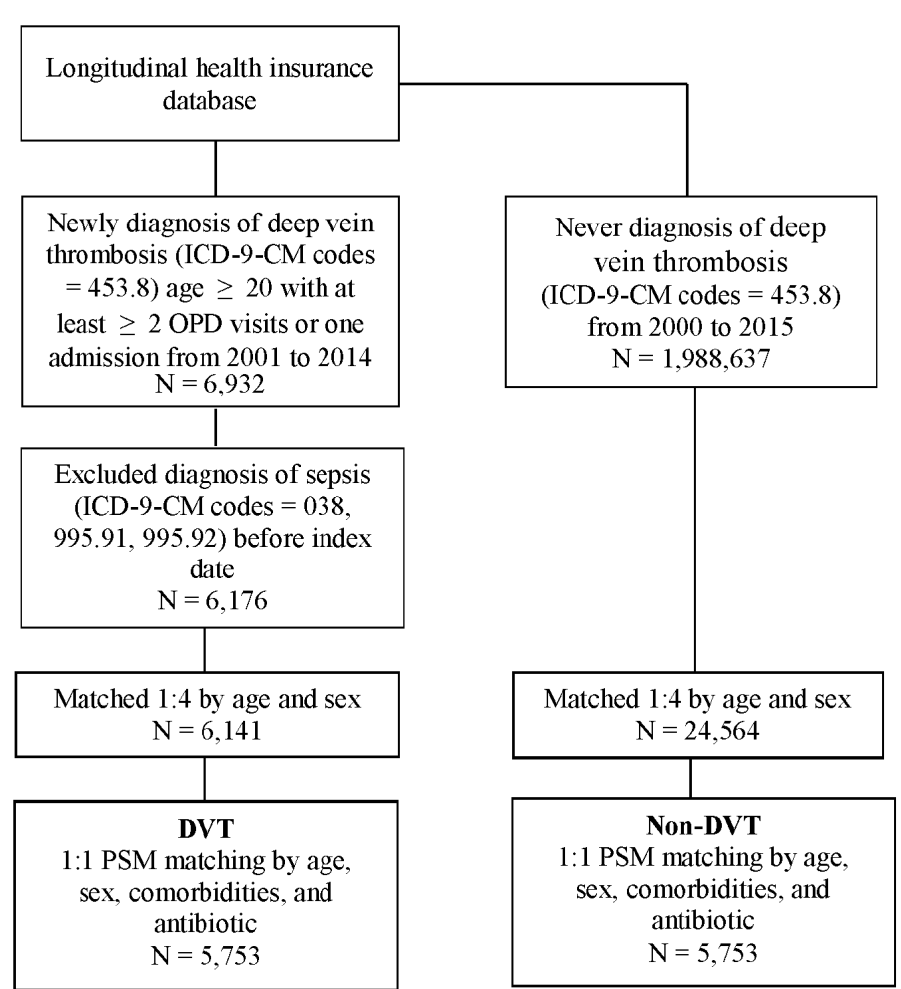
Figure 1. Flowchart of patient selection.